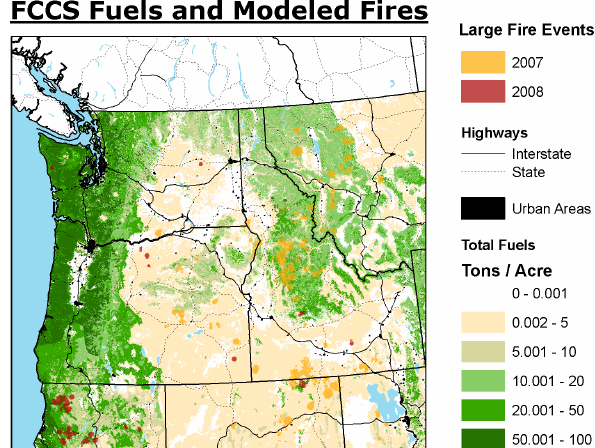
Figure 1. Fire events with individual burn areas greater than 5000 acres during the analysis periods of 2007 (orange) and 2008 (red). Total fuel loading derived from the FCCS v1 is also shown for the AIRPACT-3